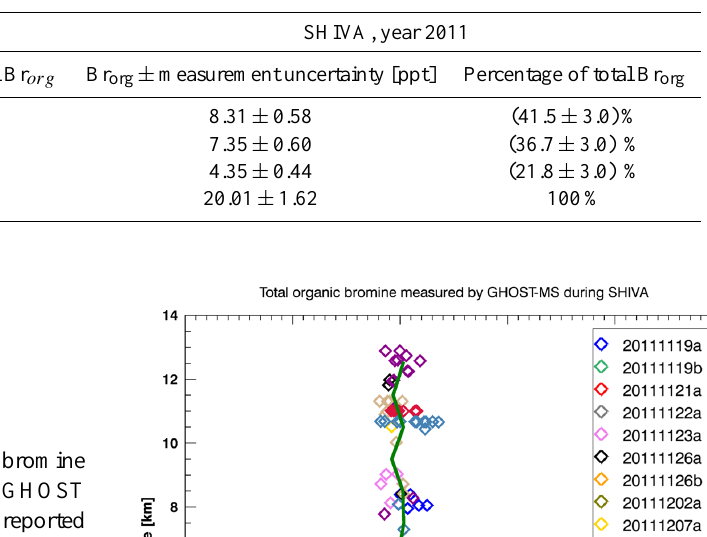
Table 10. Comparison of the total organic bromine in the upper troposphere between SHIVA and the global average in 2011. The data given for the global average of H-1301, H-1211, H-2402 and CH 3 Br are an update of Montzka et al. (2003), H-1202 is taken from Newland et al. (2013) and the VSLS data are from Montzka and Reimann et al. (2011). For the calculation of the total organic bromine, the mean mixing ratio (given in Tables 7 and 9) of an individual source gas is multiplied by its number of bromine atoms. The measurement uncertainty is the sum of scale accuracy and instrumental measurement precision.